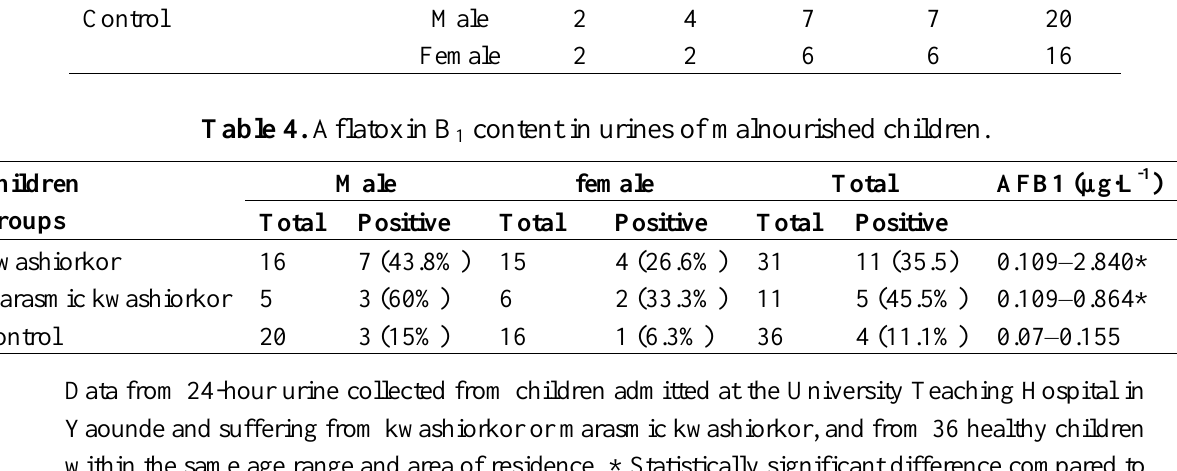
Table 2. Aflatoxin M